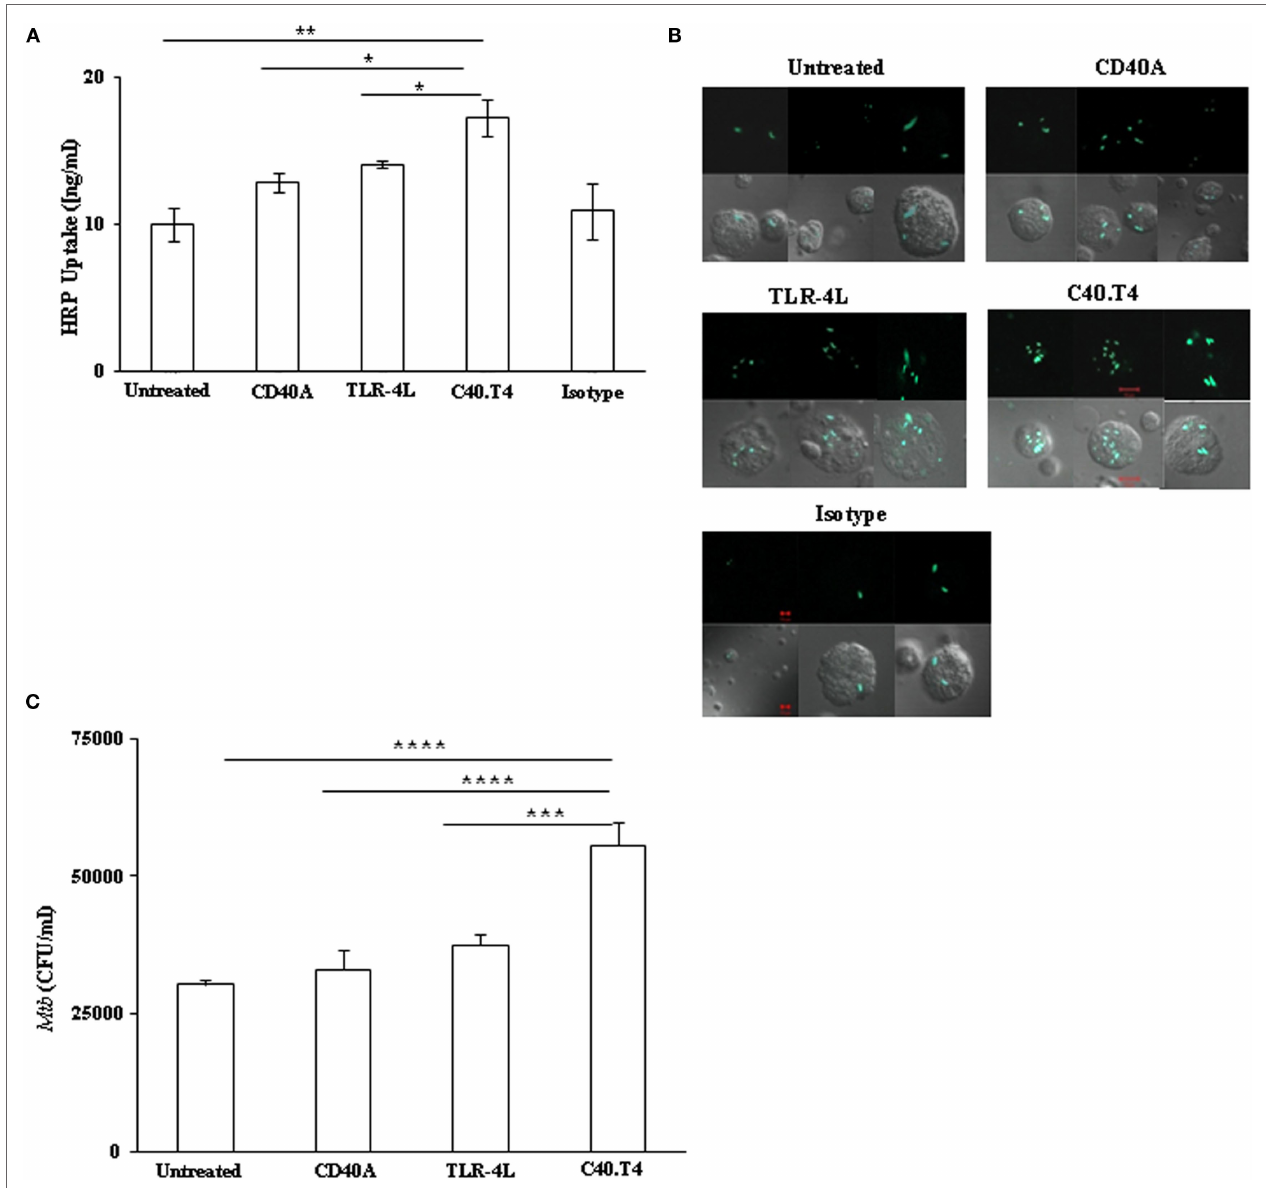
FigUre 2 | c40.T4 augmented the antigen uptake capacity of Dcs . (a) C40.T4 stimulated DCs were pulsed with antigen HRP for 60 min. Cells were washed and lysed to measure HRP uptake by colorimetry. Values were normalized with experimental blank and control cells kept on ice. (B) C40.T4 activated DCs were co-cultured with GFP-expressing Mtb ( gMtb ) for additional 4 h and were imaged through confocal microscopy. Each image represents the cells from three different fields. (c) C40.T4 activated DCs were infected with Mtb for 4 h. Later, mycobacterial uptake was enumerated by CFUs plating. Results are expressed as mean ± SD (a,c) . Data are the representative of three individual experiments. “*” and “**” indicate p < 0.05 and p < 0.01,